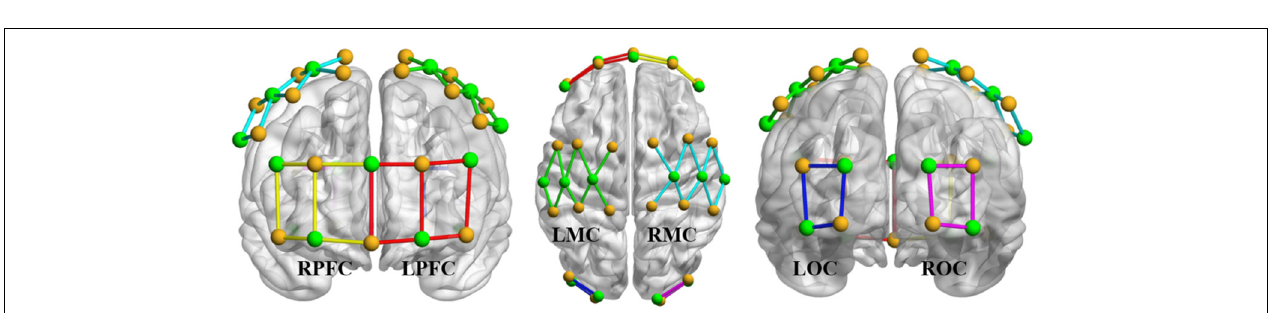
FIGURE 4 | Light source (yellow), probe (green), and channel layout. The yellow dot represents the light source, the green dot represents the detector, the LPFC channel is marked with the red line segment, the RPFC channel is marked with the yellow line segment, the LMC channel is marked with the green line segment, the RMC channel is marked with the cyan line segment, the LOC channel is marked with the blue line segment, and the ROC channel is marked with the pink line segment.